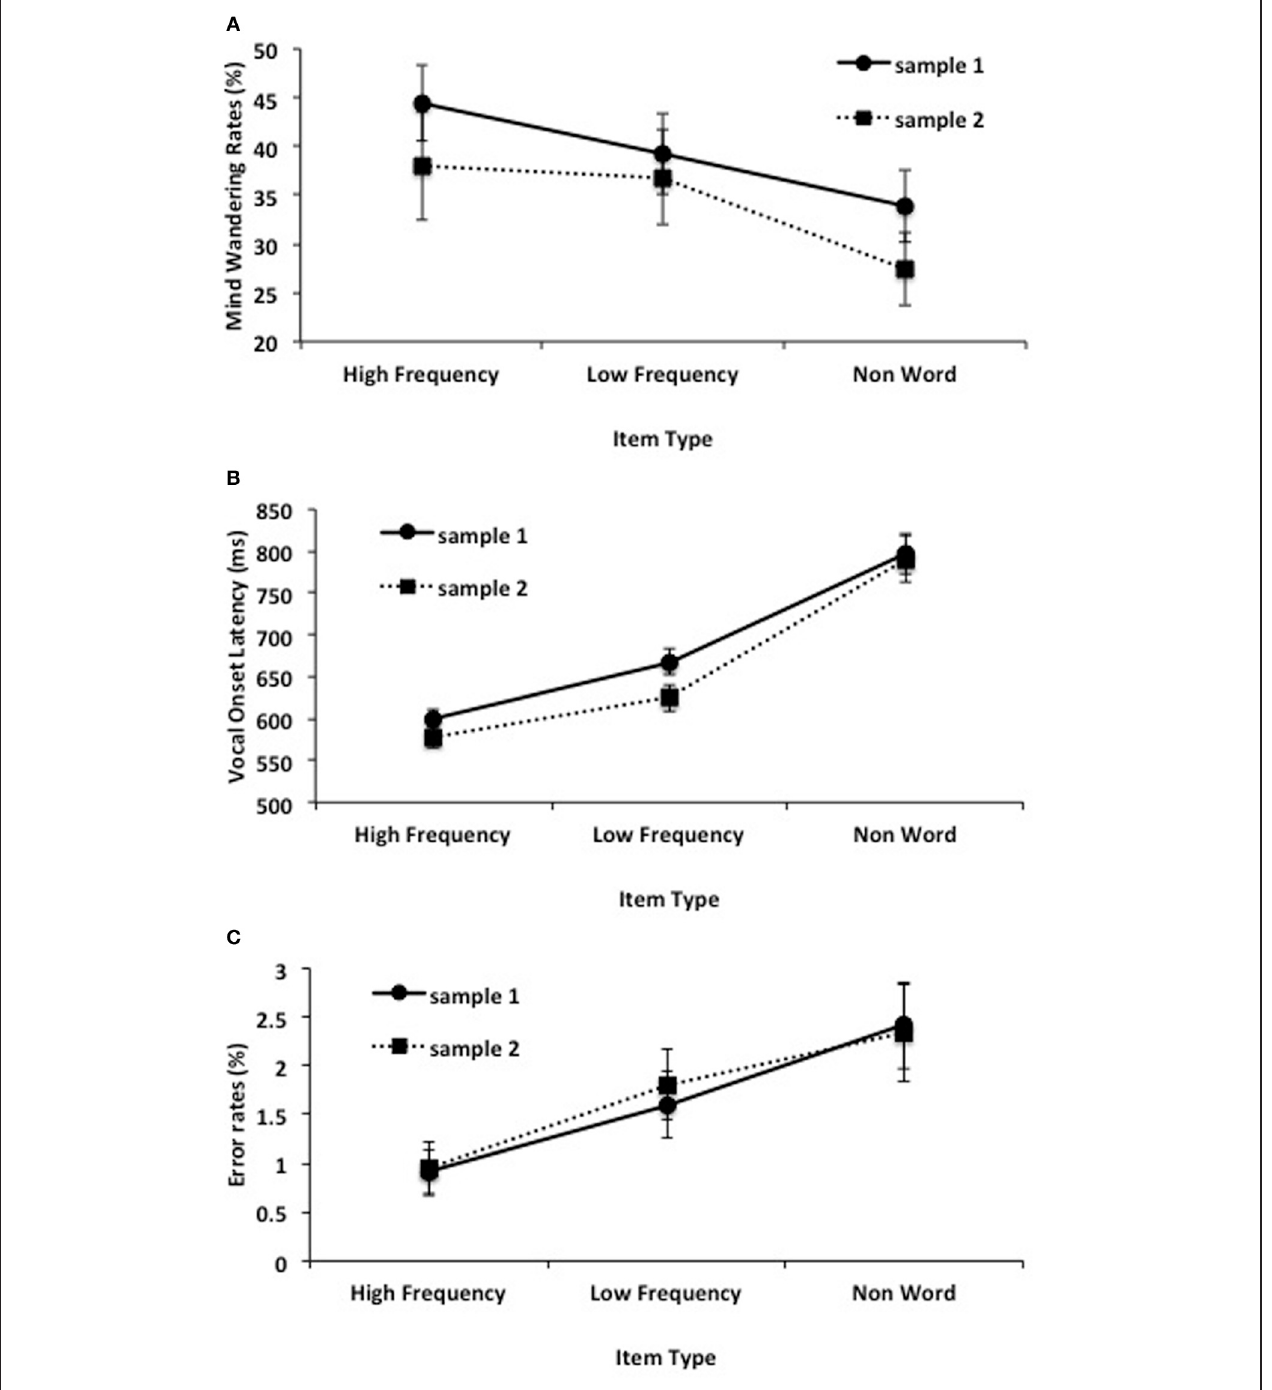
FIGURE 1 | (A) Mean percentages of “off-task” responses to the thought probes as a function of item type and sample. (B) Mean vocal onset latencies for reading aloud as a function of item type and sample, and (C) corresponding error percentages. Error bars represent one standard error of the mean.